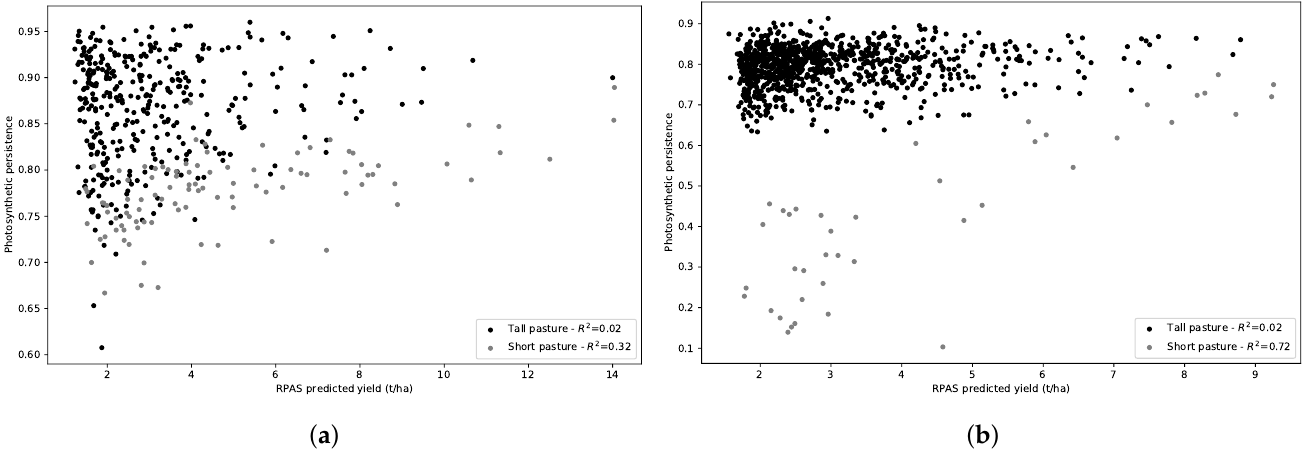
Figure 9. Relationship between the RPAS estimated yield and Planet Dove satellite image data persistent photosynthetic pasture for both the grassland ( a ) and woodland ( b ) field plots. Dark points indicate the tall pasture form and the grey points the short form.